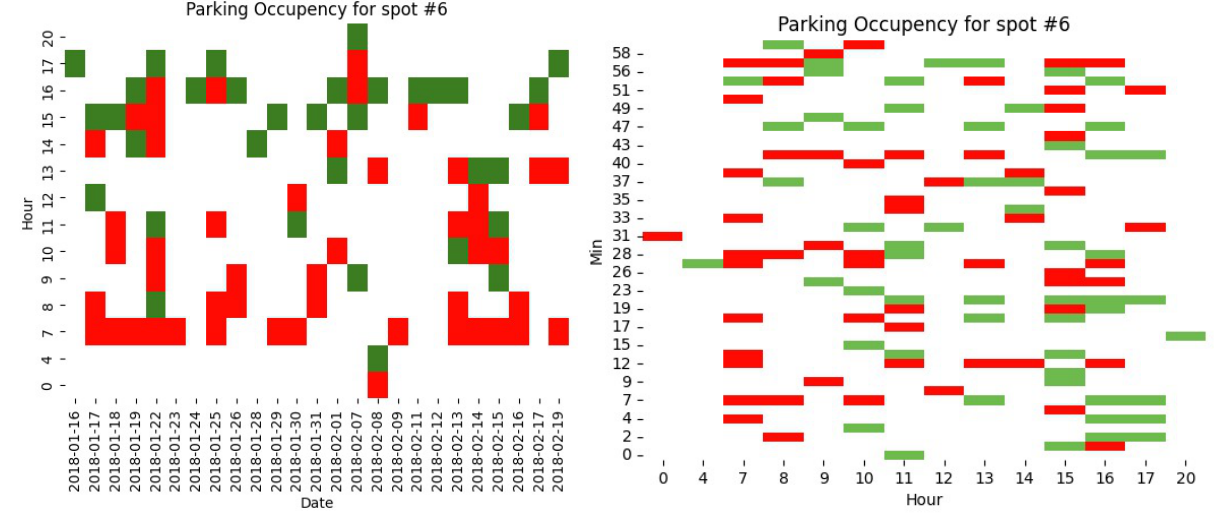
Figure 13. Heat maps of parking spaces for spot #6. For every hour of the 25 days ( Left ). For every minute of the 20 h ( Right ).